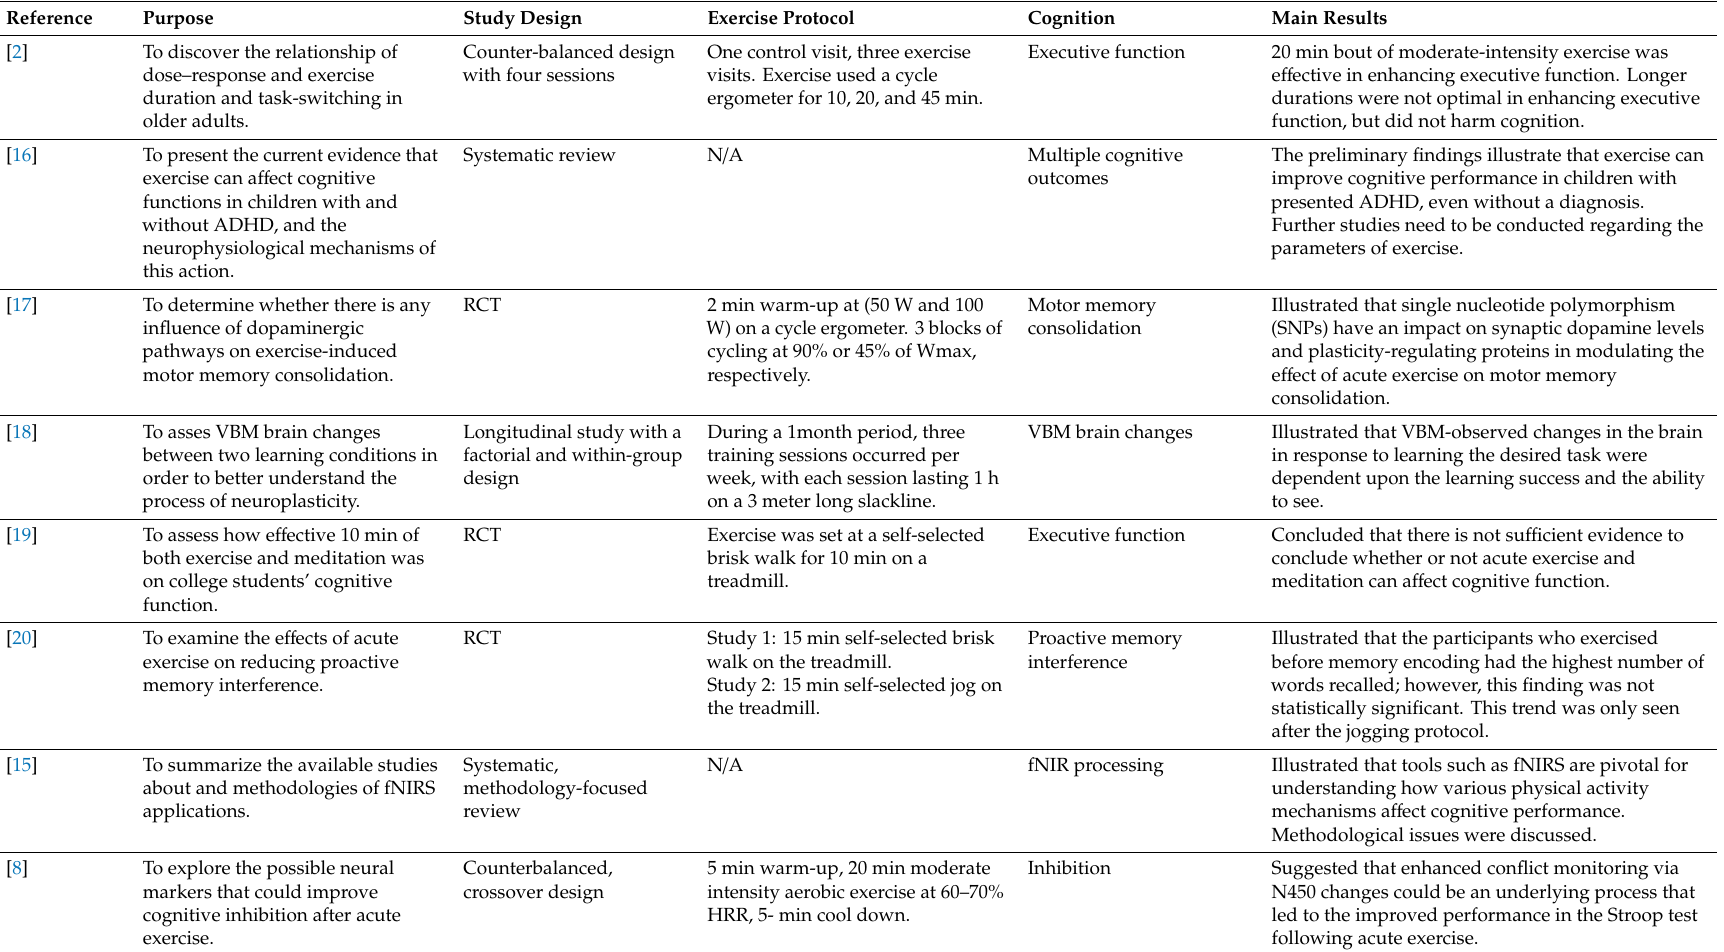
Table 1. Summary of published papers in this Special